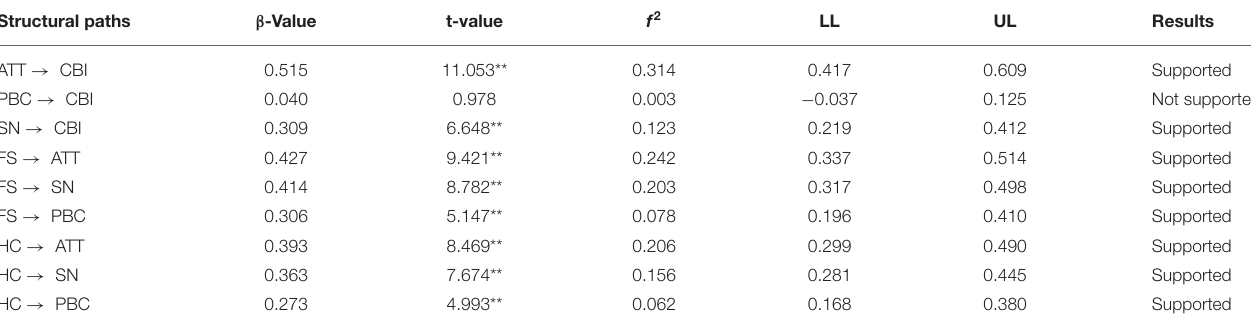
TABLE 5 | Assessment of structural paths (Hypothesis testing). Structural